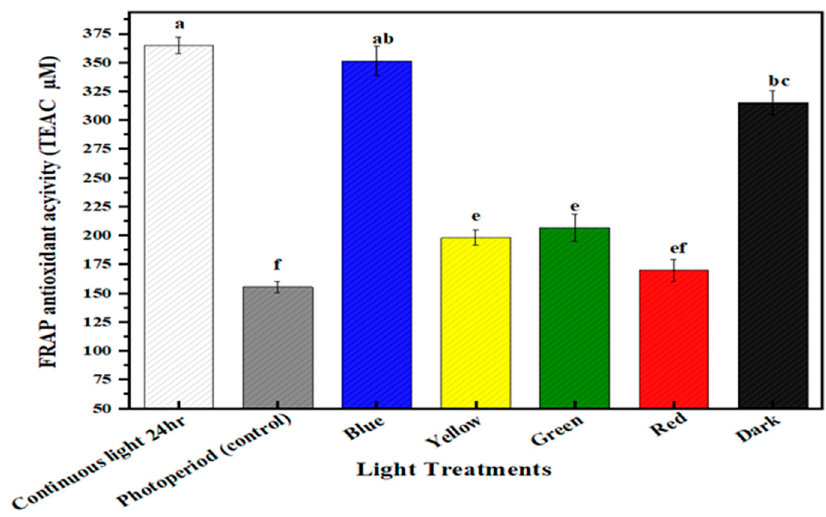
Figure 6. In vitro antioxidant FRAP activities of callus culture of M. oleifera under different light treatment. The columns with similar letters are not statistically significant at p < 0.05.